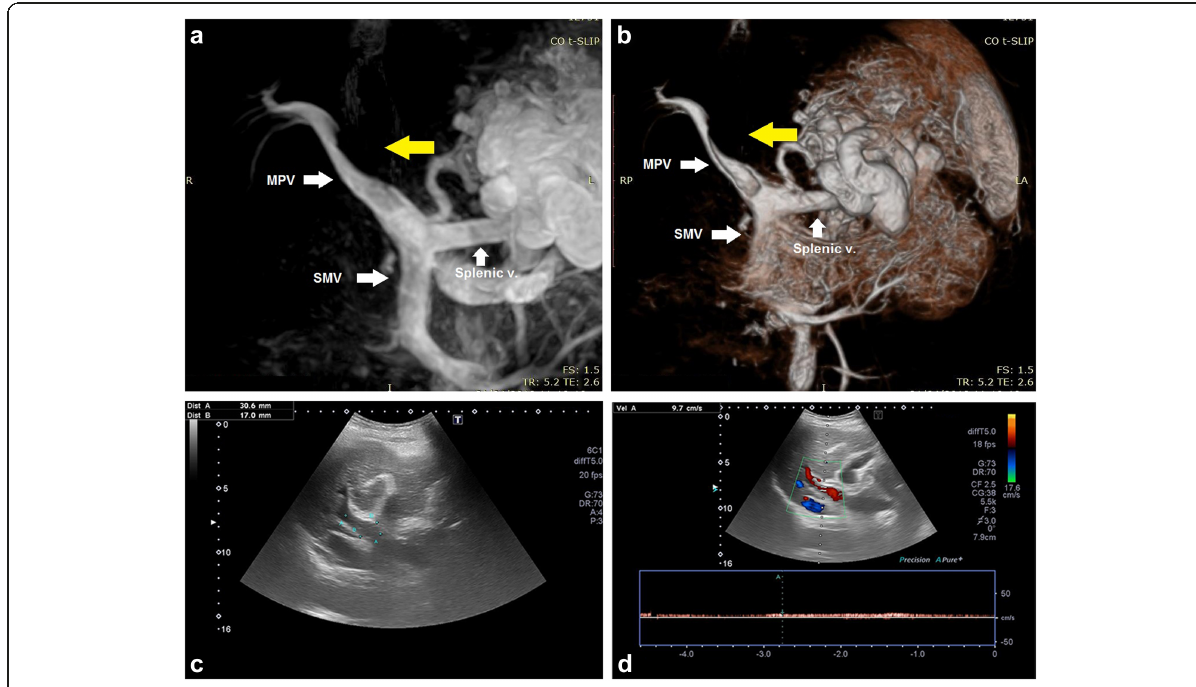
Fig. 5 Partial thrombosis of main portal vein. Coronal MIP image ( a ) and 3D volume-rendered image ( b ) from a non-contrast MR portography using T-SLIP sequence showing eccentric mural narrowing of the main portal vein (yellow arrow) representing partial thrombosis. Greyscale ultrasound image of the same patient ( c ) shows echogenic material within main portal vein, with partial color saturation and Doppler flow detected at color duplex ultrasound image ( d ) denoting partial thrombosis confirming non-contrast MR portography finding. MPV, main portal vein; SMV, superior mesenteric vein